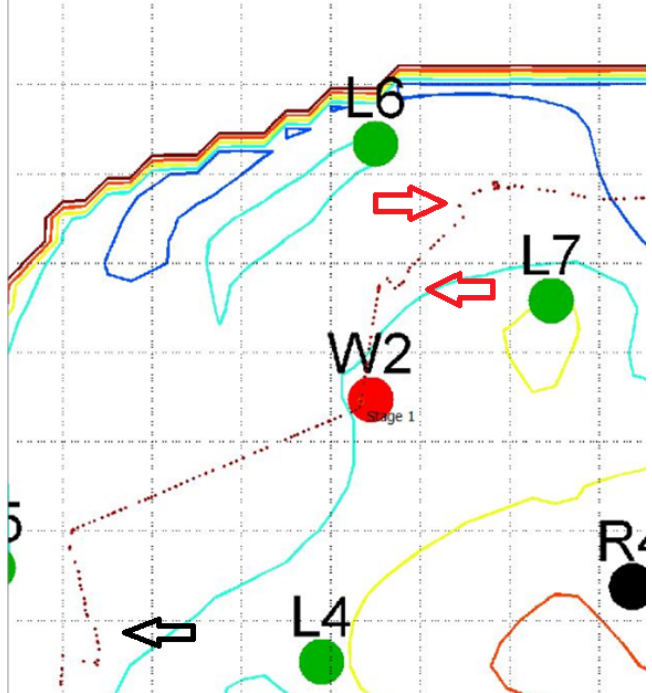
Figure 15. A mobile vehicle with a vision system on the test track. The red arrows point places where the vision system corrected the vehicle positions. The brown line is the path of the